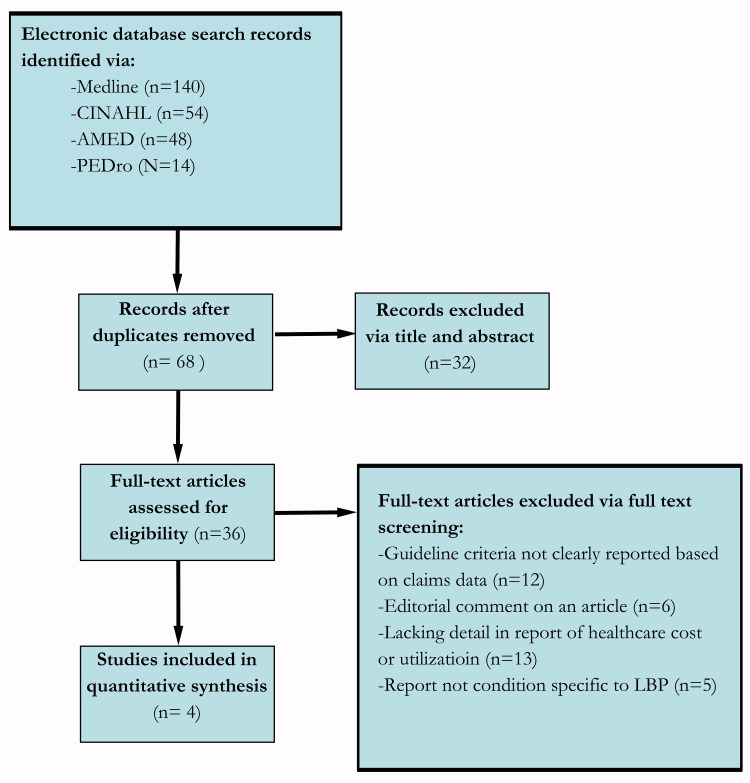
PRISMA flow diagram.